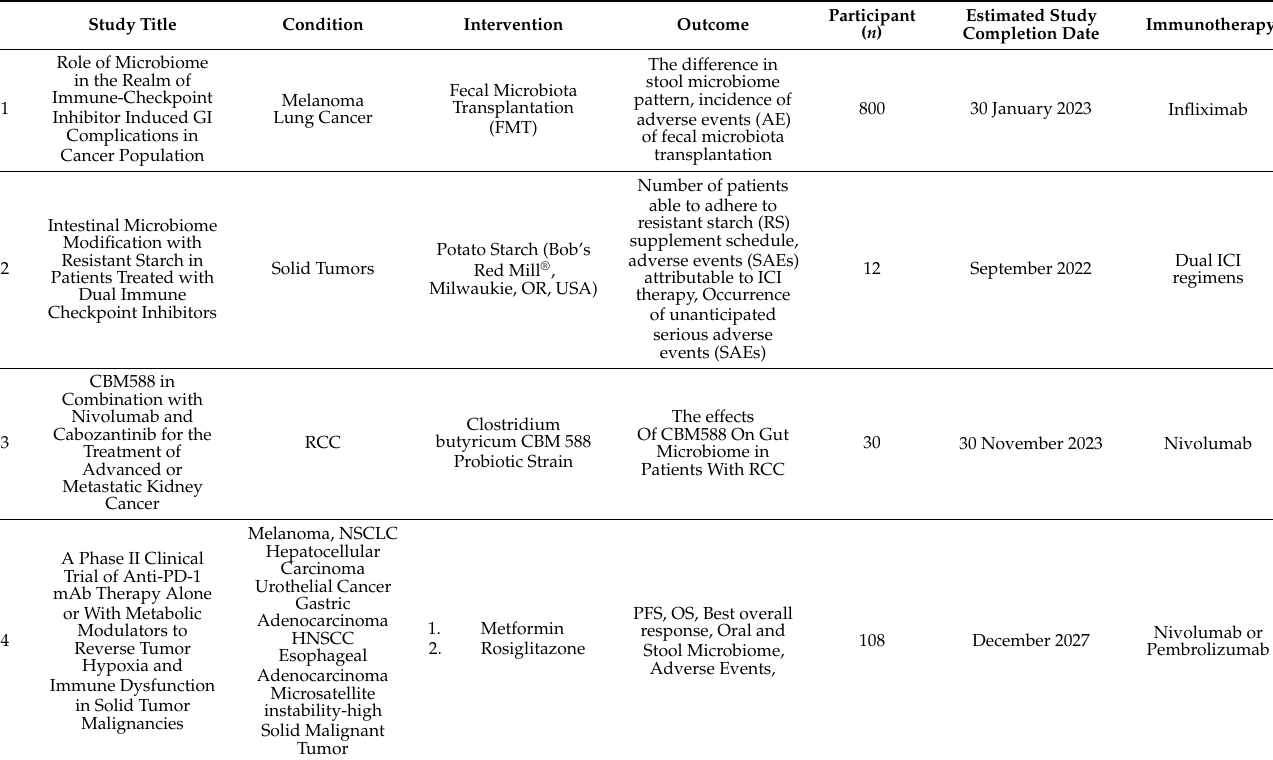
Table 1. Ongoing Clinical Trials * Testing Microbiome Impact on the Efficacy of